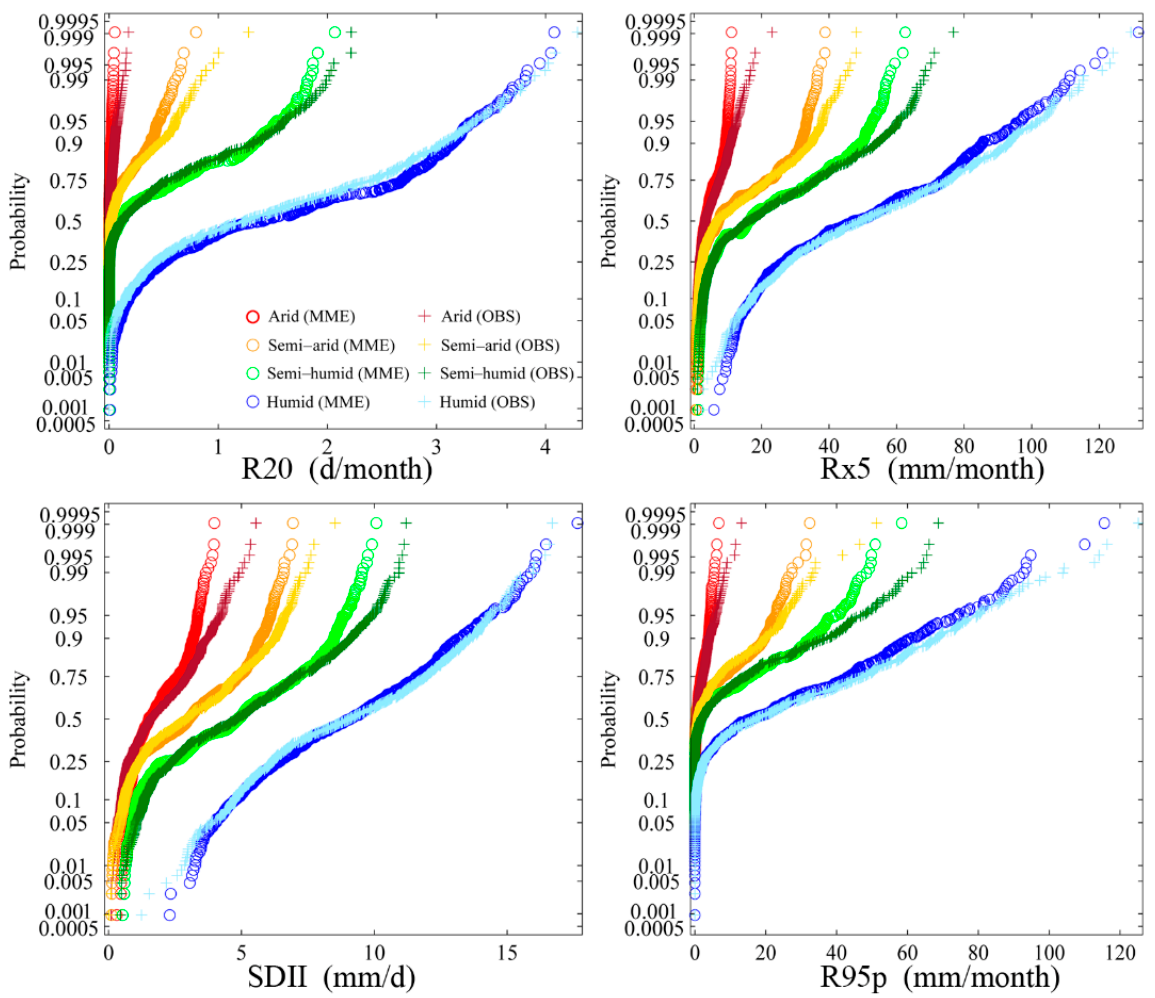
Figure 4. Cumulative probability distribution of extreme values of four precipitation indices (R20, Rx5, SDII and R95p) in four regions based on multi-model ensemble mean (MME) and observation data.